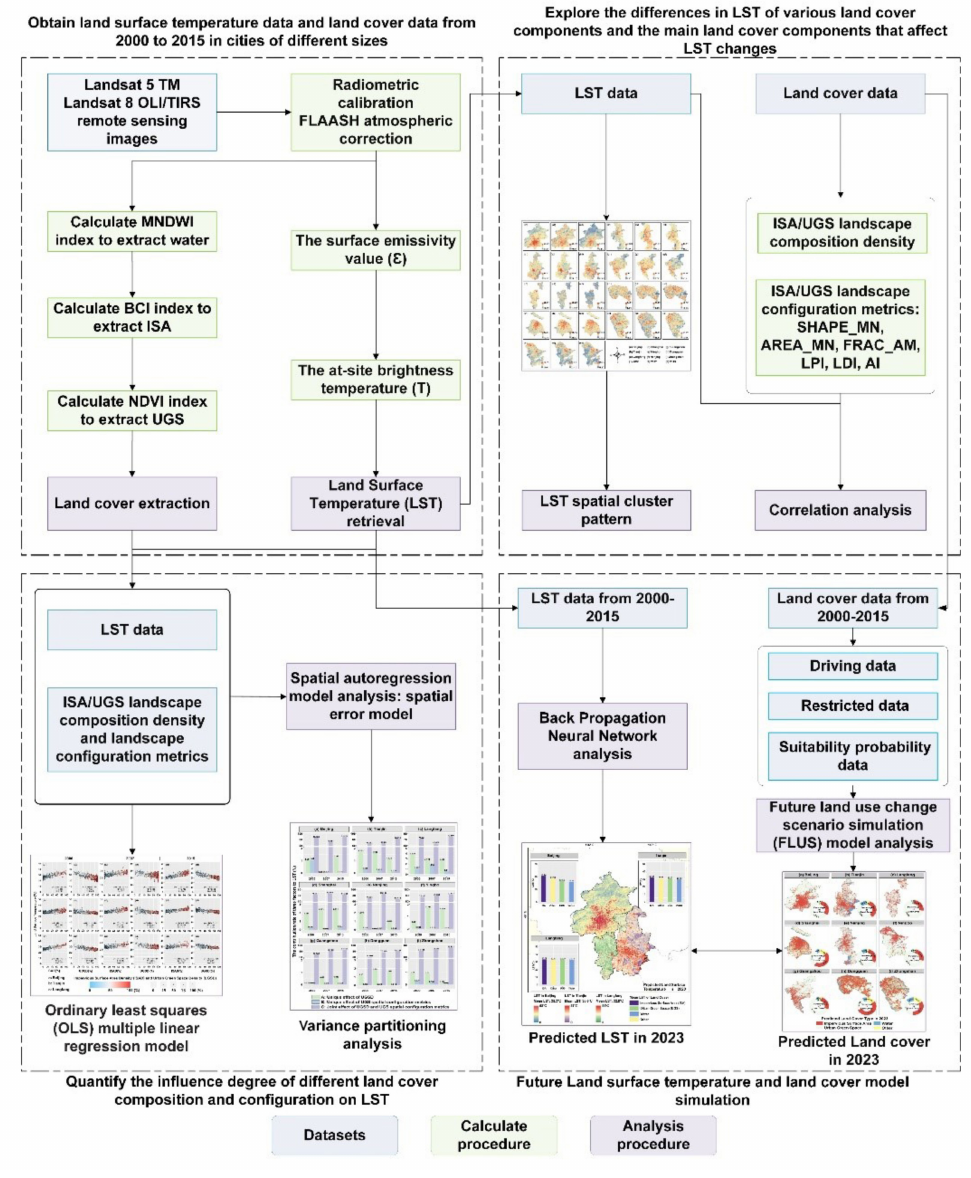
Figure 2. The analysis procedure of this